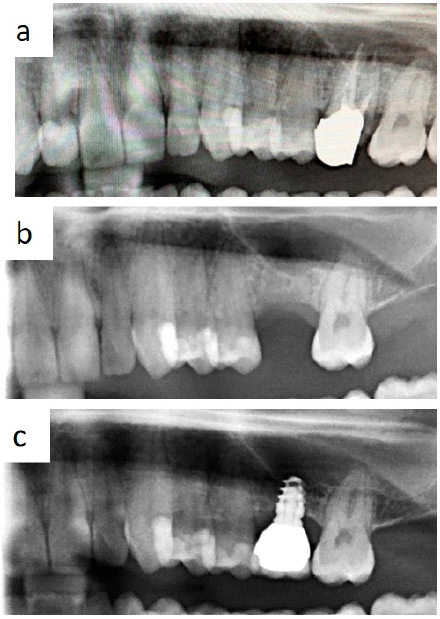
Figure 2. Occurrence of severe atrophy after removal of decayed first molar with periapical lesions ( a , b ); single tooth prosthetic rehabilitation without conventional sinus lift is feasible with short implant use ( c ).